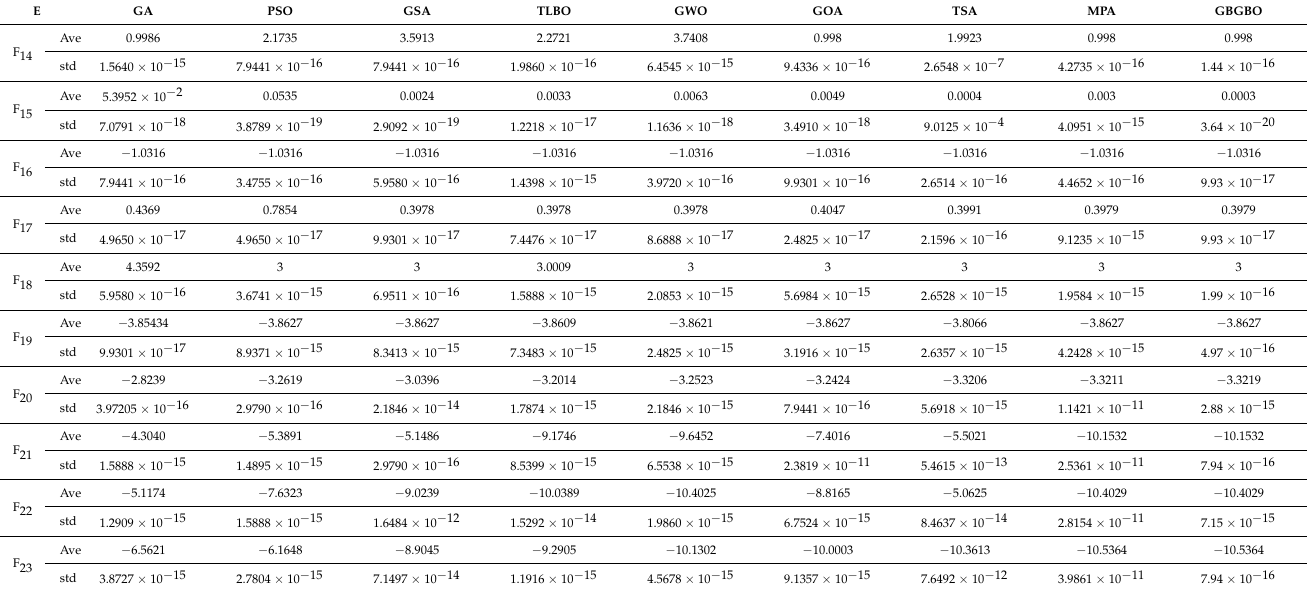
Table 4. Optimization results of GBGBO and other algorithms on fixed dimensional test